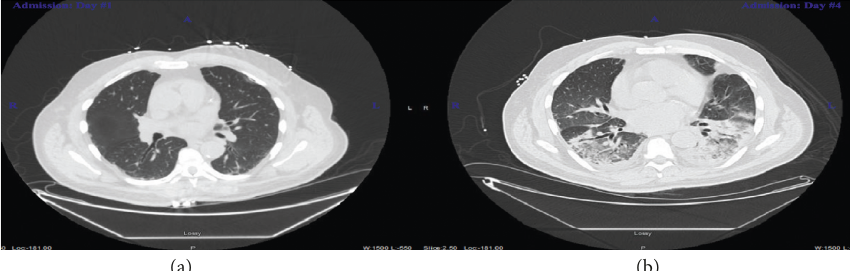
Figure 2: Contrast-enhanced chest computed tomography. (a) No filling defect in the main or lobar branches of the pulmonary arteries. Evidence of mild subsegmental atelectasis in the lung bases is seen. There are no airspace infiltrates, focal consolidation, or pleural effusion. (b) New development of bilateral basilar infiltrates and consolidations without pleural